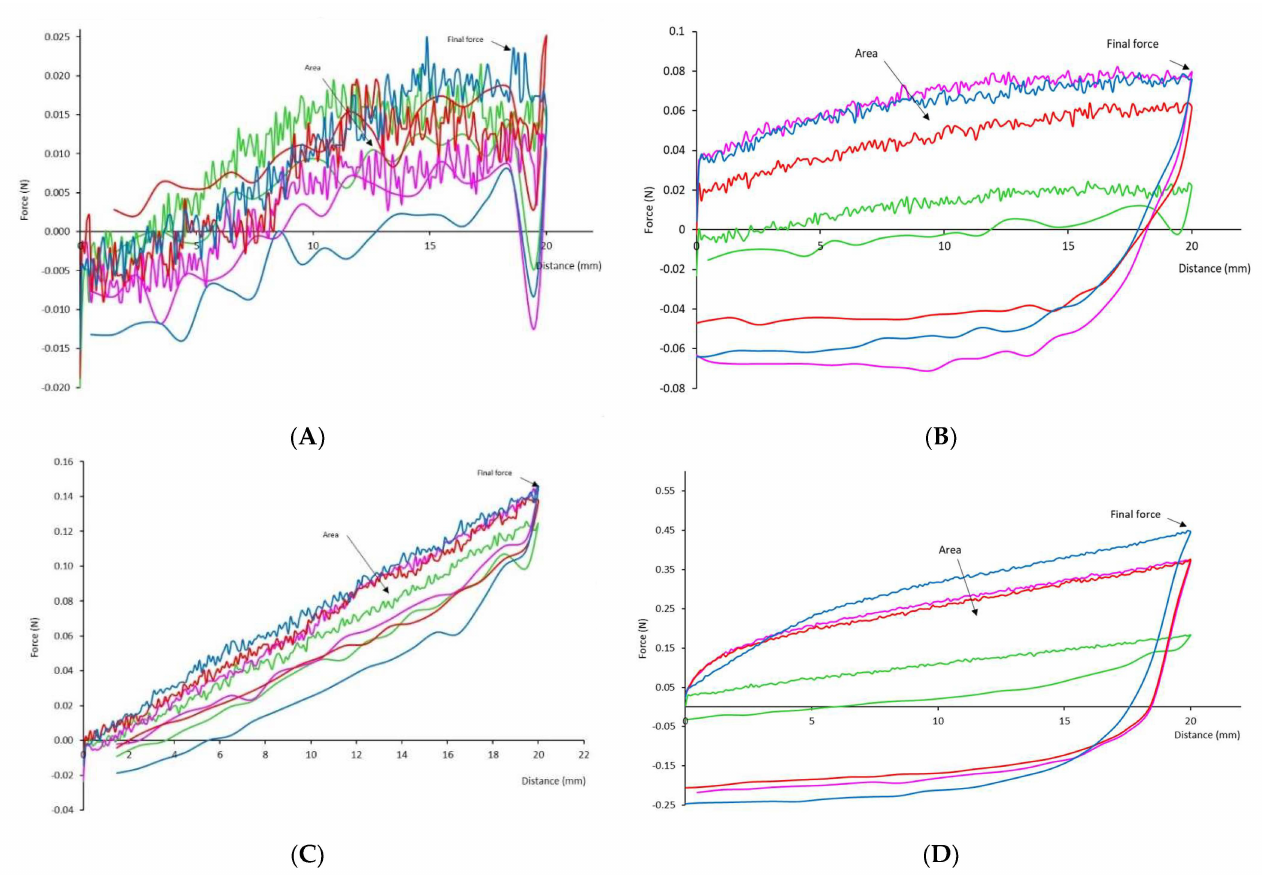
Figure 2. Force–deformation curve of the four thickeners derived from the penetration test with sphere probe (top) and cylinder probe (bottom) at speed of 1 mm s − 1 (Left: nectar; Right: pudding). Different colors indicated different thickeners: green—thickener ( A ), pink—thickener ( B ), red— thickener ( C ), and blue—thickener ( D ). Table 5. Penetration test values with sphere or cylinder at a speed of 1 mm s − 1 at nectar and pudding concentrations.